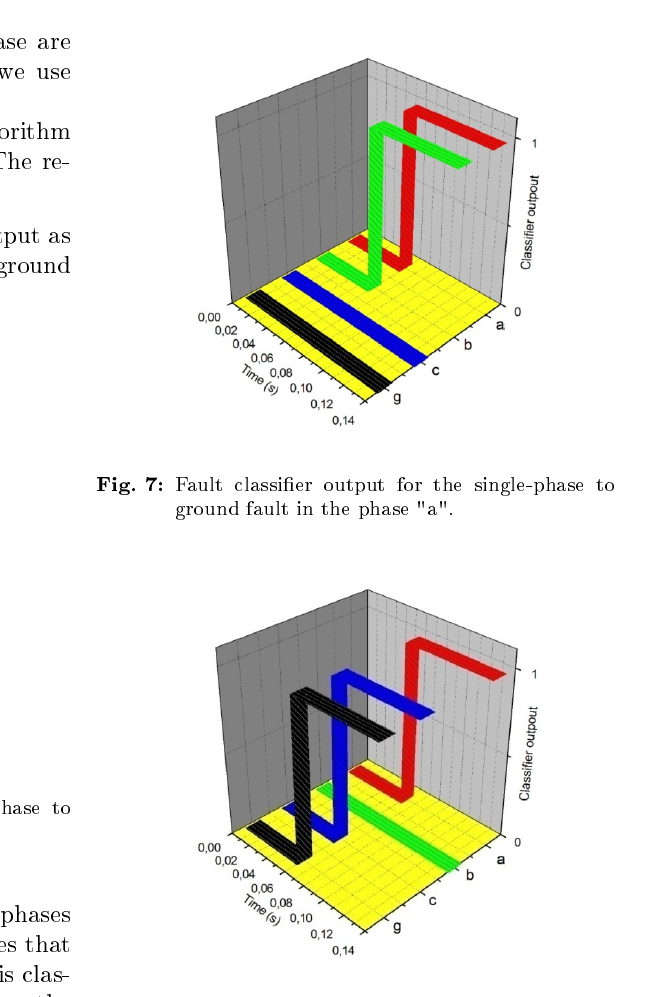
Fig. 8: Fault classi(cid:28)er output forthe double-phases fault with ground in the phases ’a’, ’c’ and the ground. phaseto ground fault (a-c-g). The fault is clas- si(cid:28)ed on phase "a" at time 0.063 sec. and on phase "c" and the ground at time 0.062 sec. so the fault classi(cid:28)cation time is equal to 0.063 sec, it’s late by 3 ms. Fig. 9 represents the fault classi(cid:28)er output as a function of time for a three-phase fault (a-b-c). The fault classi(cid:28)er indicates that the